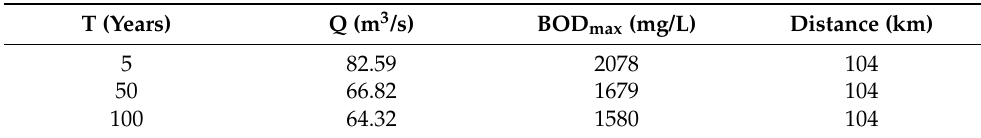
Table 4. Minimum flows for different return periods and maximum BOD concentrations that can be treated by the study section of the Biob í o